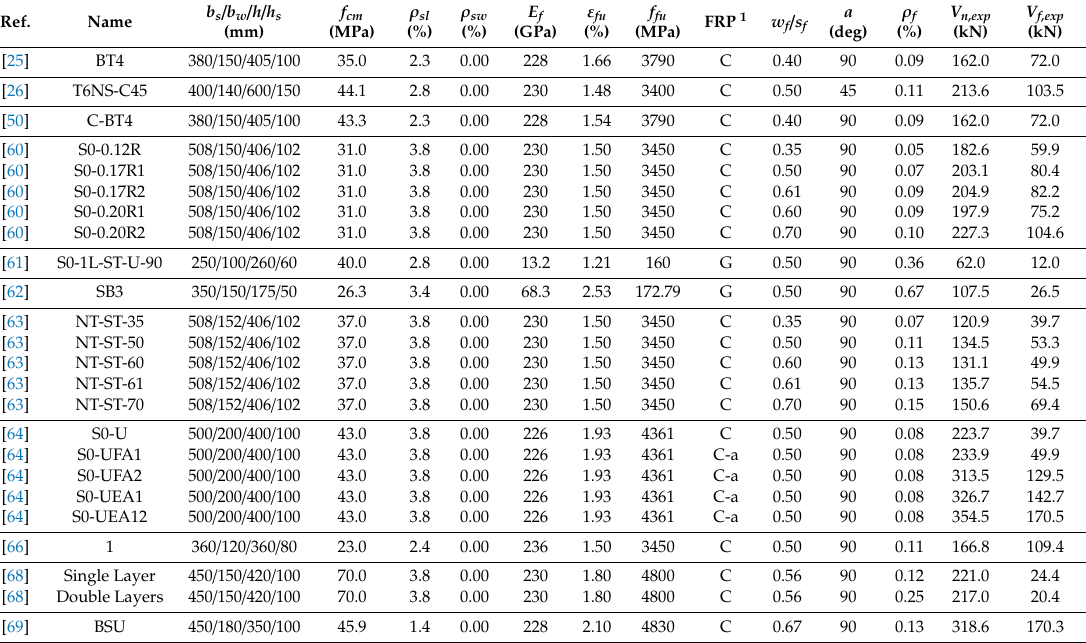
Table A4. Properties of the retrofitted T-beams with EB-FRP U-strips without stirrups of the database.